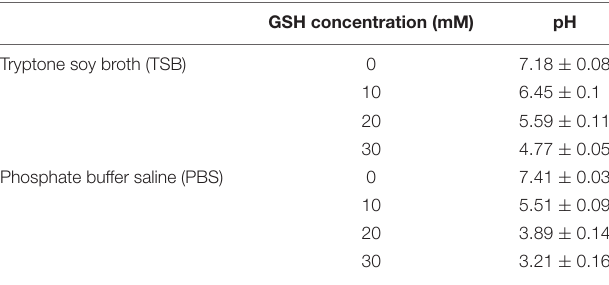
TABLE 2 | Change in pH of TSB and PBS in presence of glutathione